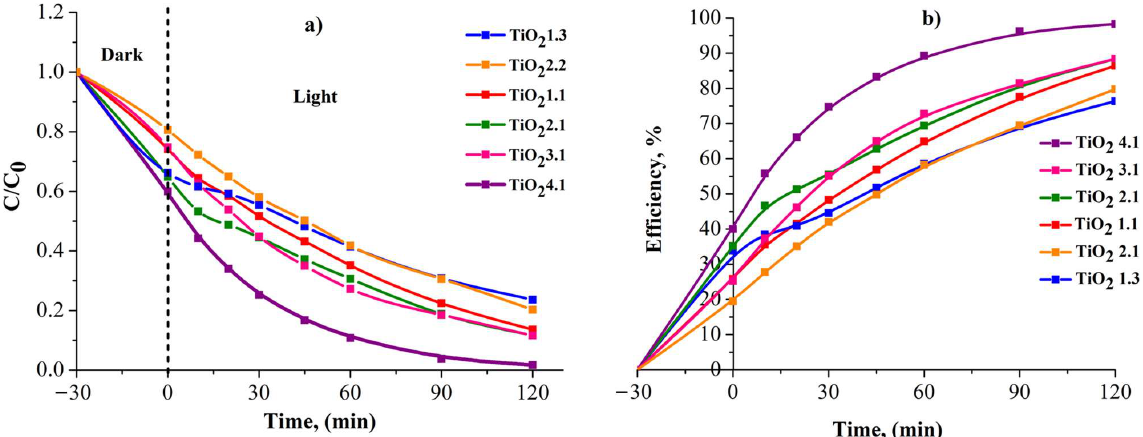
Figure 7. ( a ) Adsorption in dark conditions and photocatalytic degradation of CR dye under UV- light at equilibrium, ( b ) removal efficiency of CR dye in the presence of the synthesized titania photocatalysts; note that the initial concentration of CR dye was 50.0 mg/L, and the dosage of TiO 2 catalyst 1 g/L; at a working temperature of T = 20 ± 2 °C.